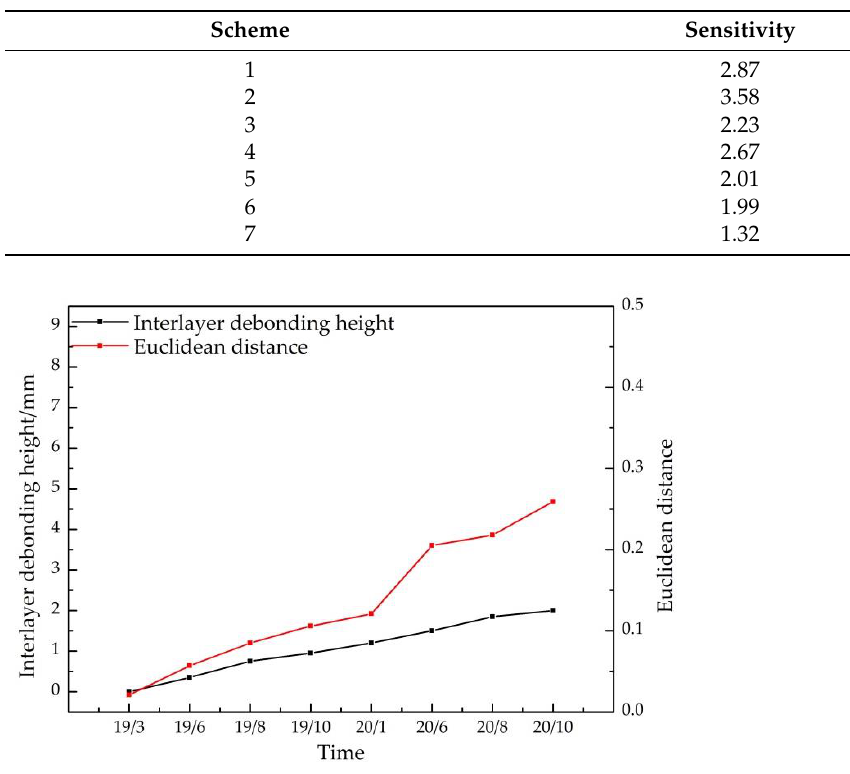
Table 10. Sensitivity of seven features fusion methods.